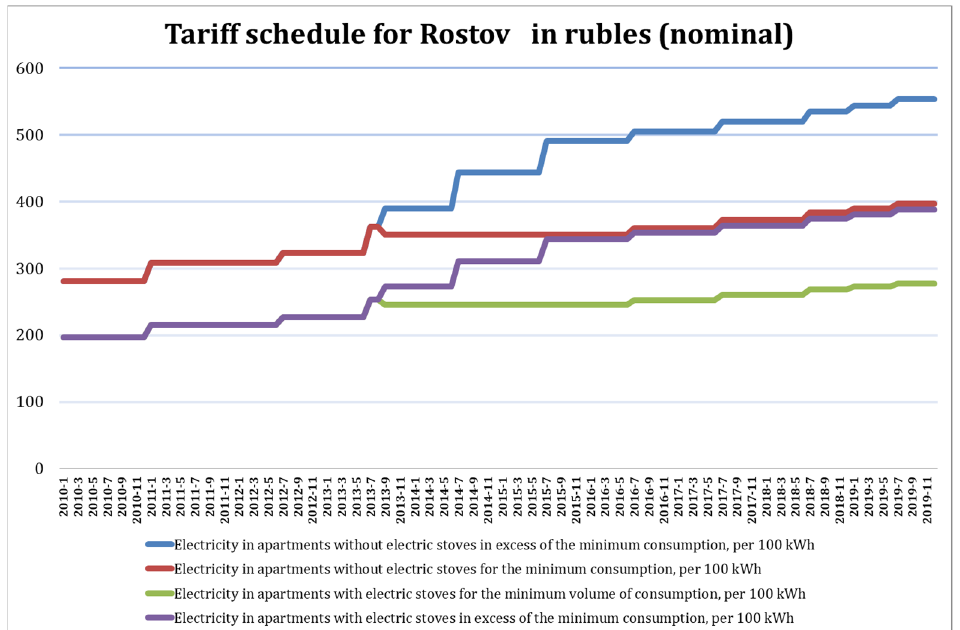
Energies 2021 , 14 , x FOR PEER REVIEW Figure A2. Electricity Tariff Schedule for Rostov (2010–2019). Source: Federal State Statistics Service.